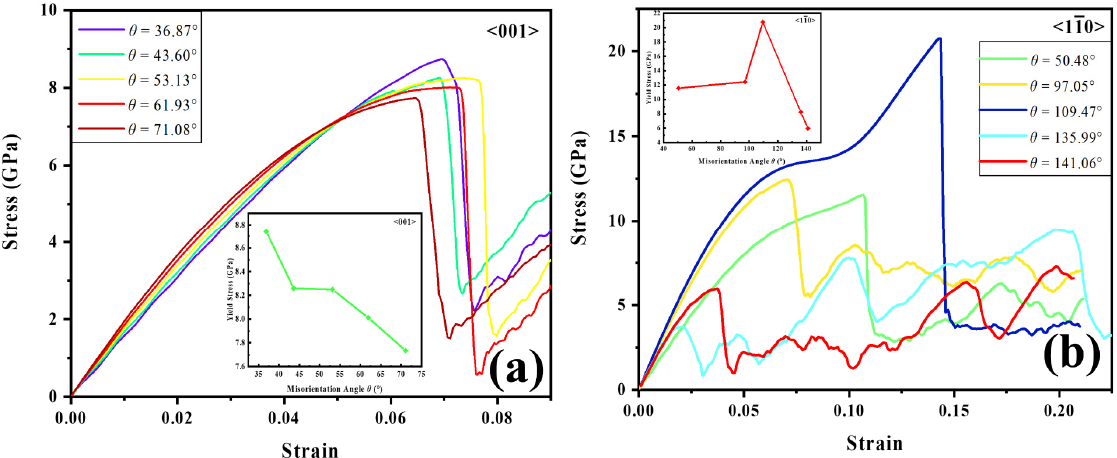
(cid:10) (cid:11) 110 STGBs. The insets show the dependency of